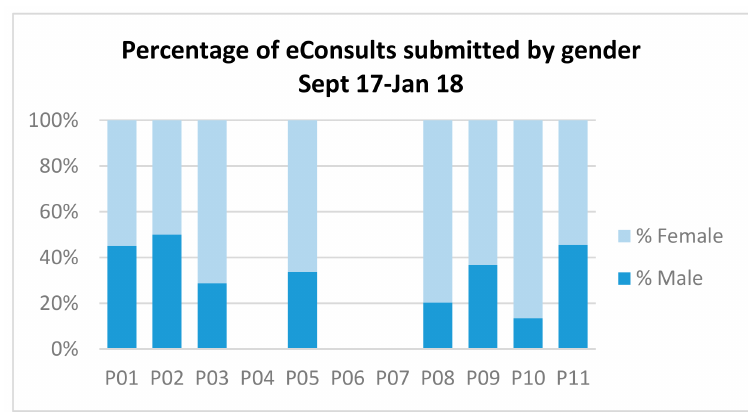
Figure 4. Percentage of eConsults submitted by gender 17 September–18 January.